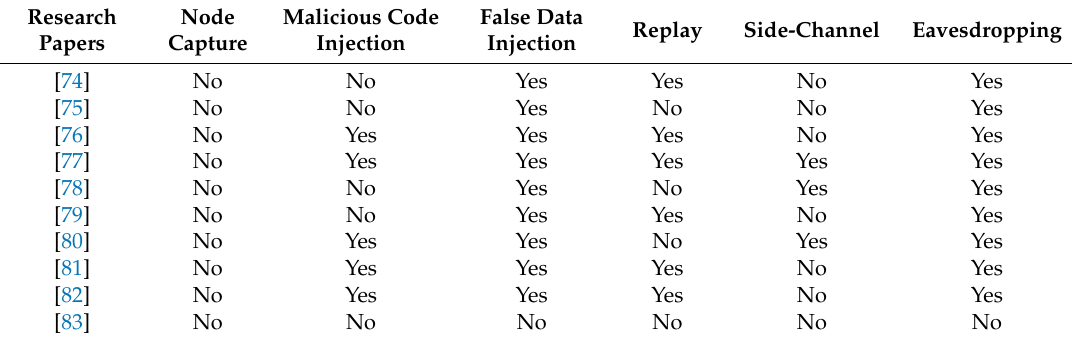
Table 2. Attacks on GSB/RSB schemes.